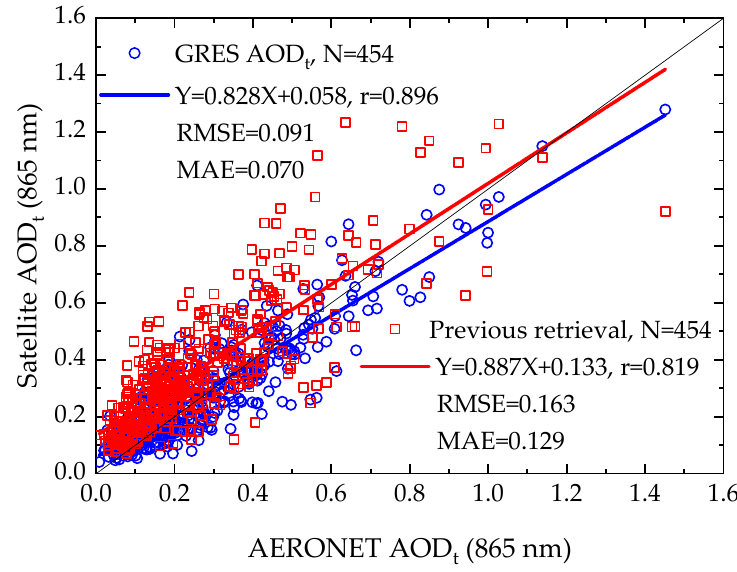
Figure 11. Comparison of the retrieved AOD t using the EOFs with the GRES and previous method against AERONET measurements.